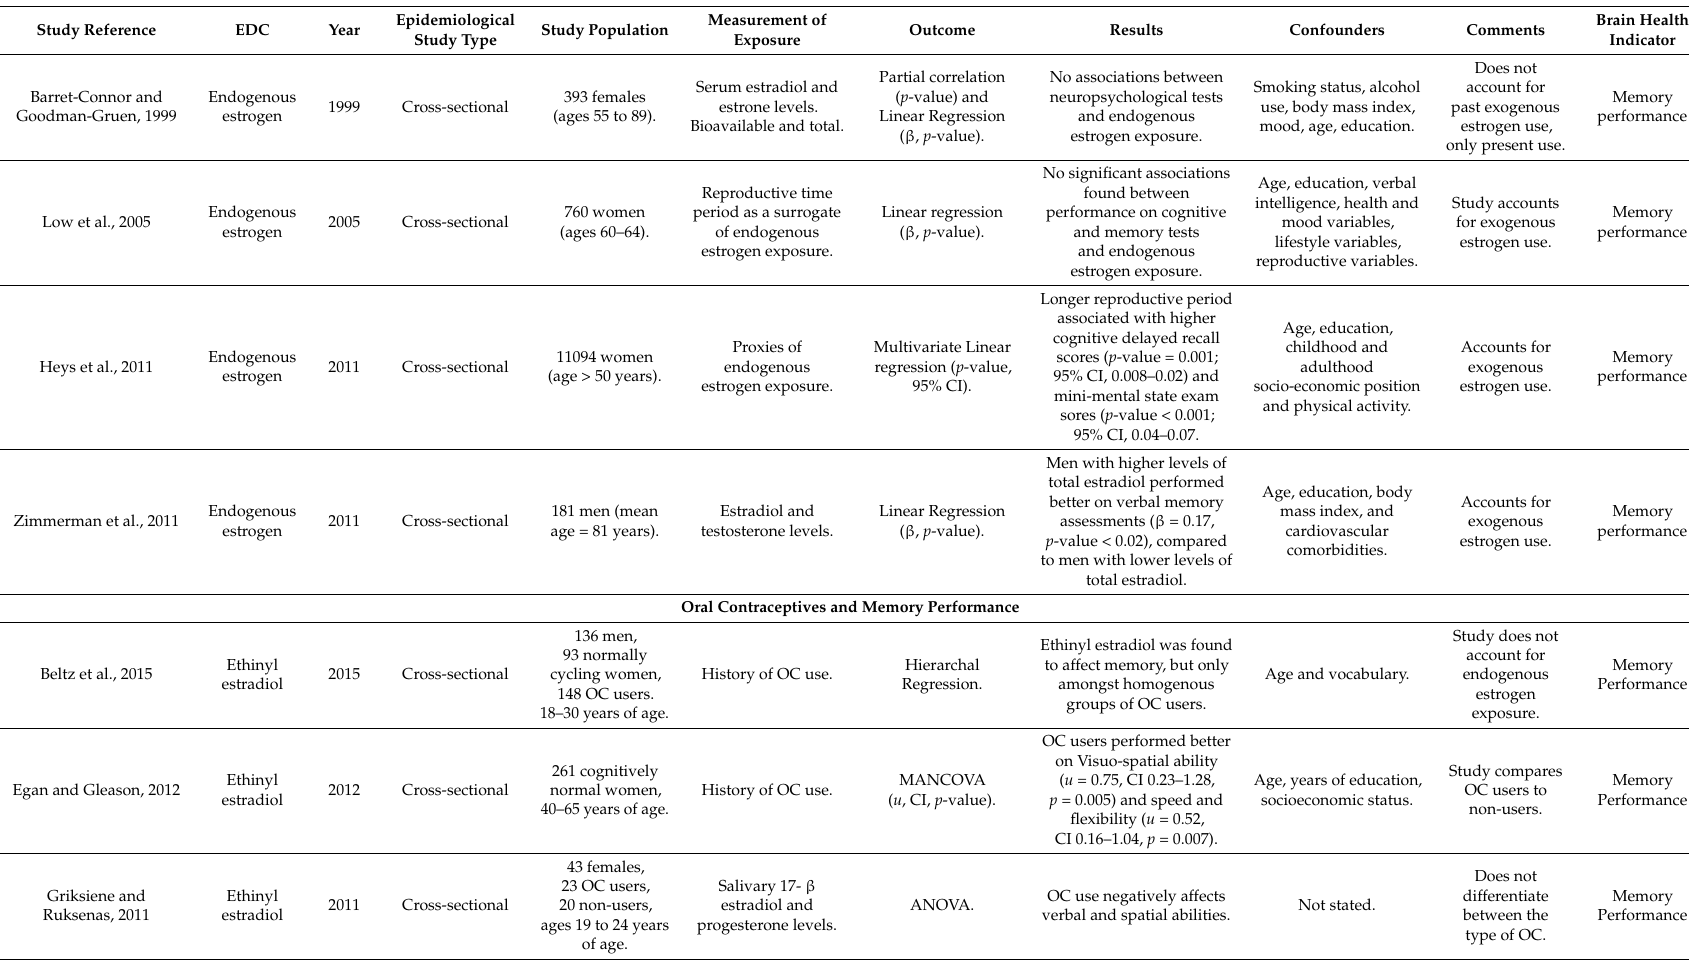
Table 2. Epidemiological studies summarizing association between endogenous estrogen, hormonal replacement therapy, bisphenol-A, and phthalates and memory performance, child behavior, and